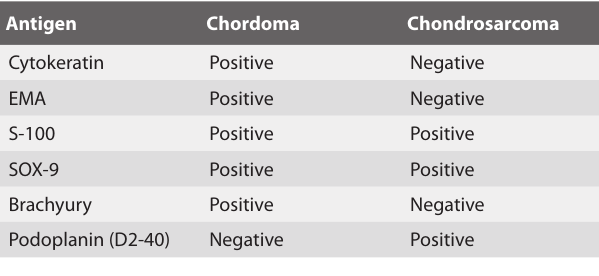
Table 1. Immunohistochemical comparison chordoma vs chondrosar- coma (EMA, epithelial membrane